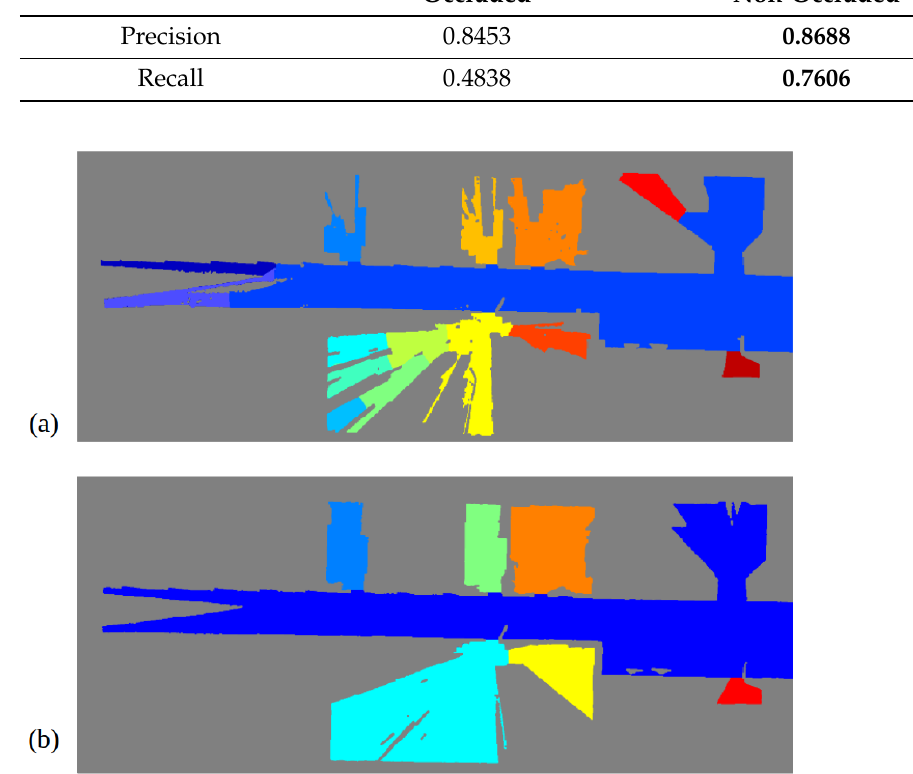
Figure 18. Segmentation results when the proposed algorithm is applied in two different maps: ( a ) floor-level map obtained from the Hokuyo laser, ( b ) derived map from a partitioning of 3D data from the Ouster LiDAR at a height of 1.7